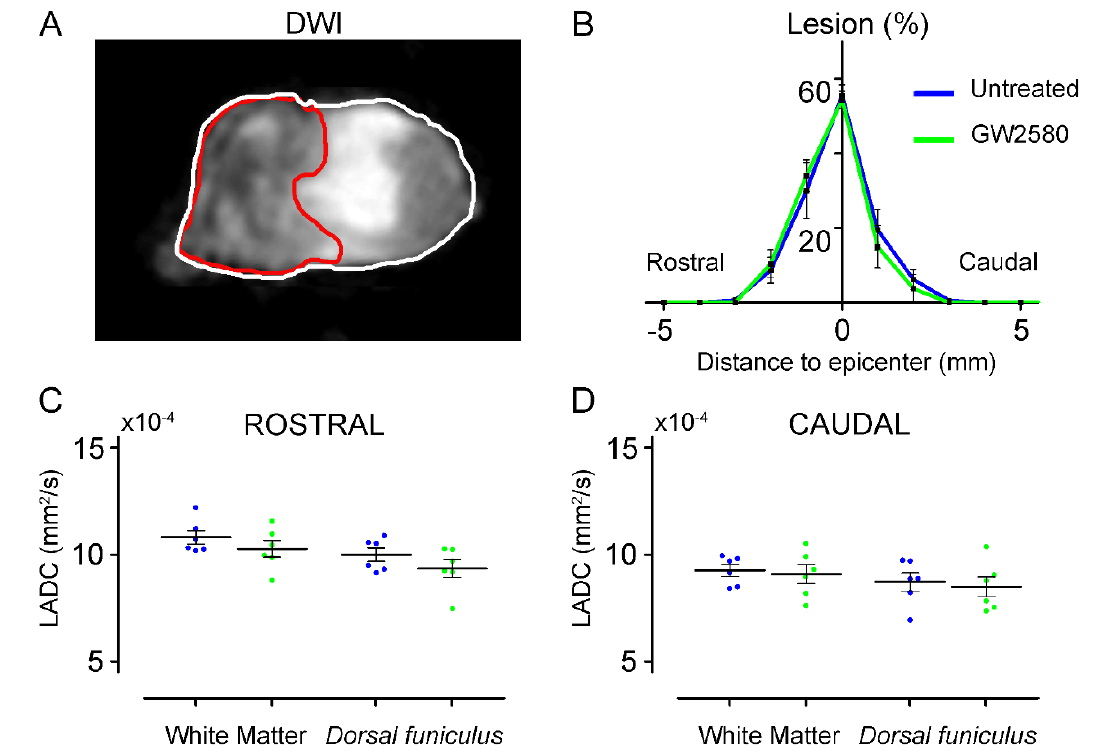
Figure 2. Long-term GW2580 treatment has no effect on lesion extension and longitudinal diffusivities. Representative ex vivo DW-MRI located at the lesion epicenter 6 weeks after injury ( A ). Axial spinal cord slice is delineated in white and lesion (here at the epicenter) in red. Line curves showing lesion percentages at epicenter, lesion extensions, and lesion volumes (area under the curve) in untreated (blue) and GW2580-treated (green) groups ( B ). Longitudinal apparent coefficient diffusion (LADC) rostral ( C ) and caudal ( D ) to the lesion in the white matter (excluding the dorsal funiculus ) and the dorsal funiculus . Results are expressed as mean ± SEM per time-point in untreated (blue) and GW2580-treated groups (green). Each dot corresponds to a minimum of 8 sections (1 mm interval between each section). Statistics: Student’s unpaired t -test. Number of animals: 6 mice were used per experiment and per condition.